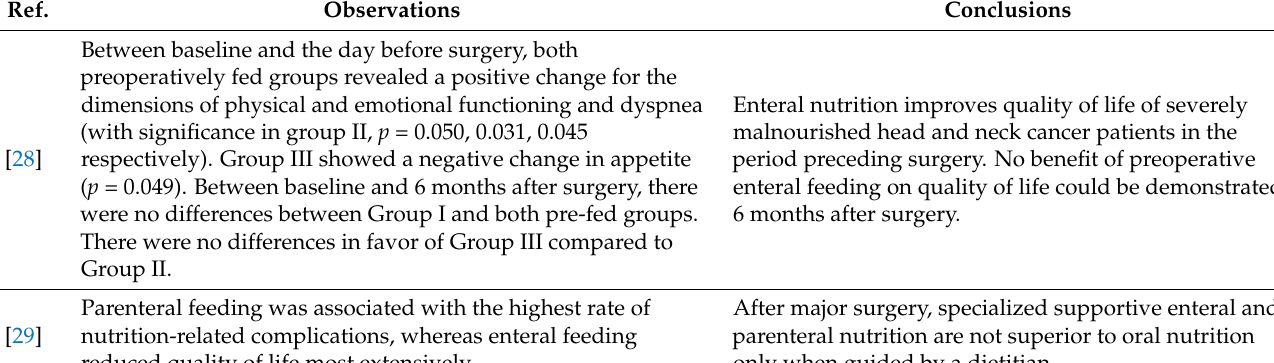
Table 7. The results and conclusions associated with the effect of the applied nutritional intervention on the quality of life within the studies included in the systematic